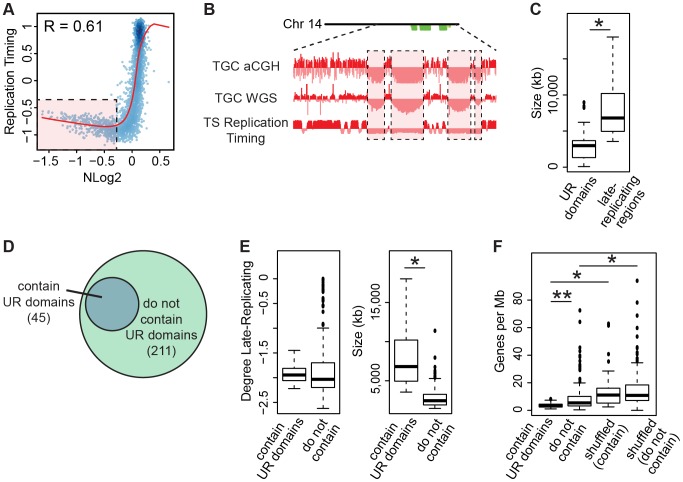
TGC UR domains are a subset of late-replicating regions in TS cells.
A. UR domains correlate with late-replicating regions in TS cells. The Pearson correlation (R) between NLog2 values of TGC vs. embryo (WGS) and average TS replication timing. Data points represent 1 Mb windows in the genome. UR domains boxed in pink. B. UR domains are late-replicating. Screen shot from the UCSC genome browser of the second half of chromosome 14 (schematic shown above screen shot) depicting the following: aCGH and WGS data from e9.5 TGCs and replication timing data from cultured TS cells. UR domains boxed in pink. C. Box plot analysis shows that UR domains are smaller than the late-replicating regions that contain them. Asterisk marks the comparison that is statistically significant (p<0.01). D. UR domains form from a subset of late-replicating regions. Diagram depicting late-replicating regions that contain UR domains versus ones that do not contain UR domains. E. Box plot analysis shows that the late-replicating regions that contain UR domains are significantly larger, but not significantly more late-replicating, than those that do not. Asterisk marks the comparison that is statistically significant (p<0.01). F. Box plot analysis shows that the late-replicating regions that contain UR domains have significantly fewer genes than those that do not (double asterisks). “Shuffled” refers to a random set of regions that have the same length and chromosome distribution. Asterisks mark comparisons that are statistically significant (p<0.01).